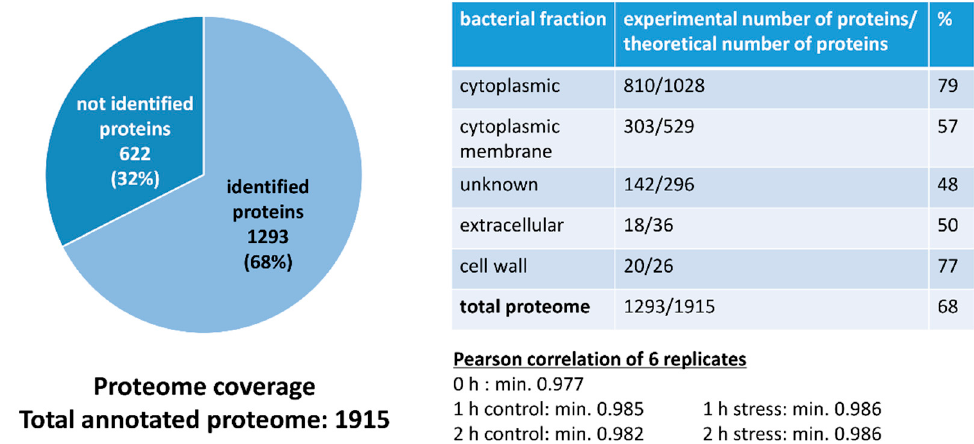
Figure 3. Graphical representation of proteome coverage and correlation of replicates.